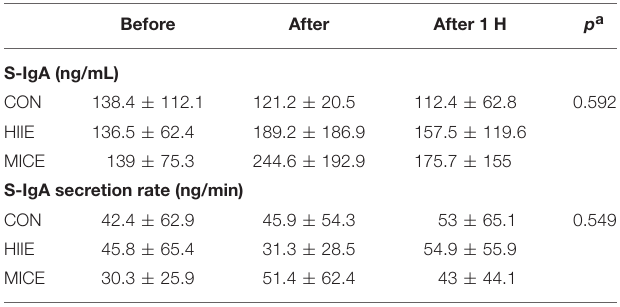
TABLE 4 | Correlation Leptin/IFN-y in different conditions (CON, MICE and HIIE) at moments before, after and 1h after exercise.